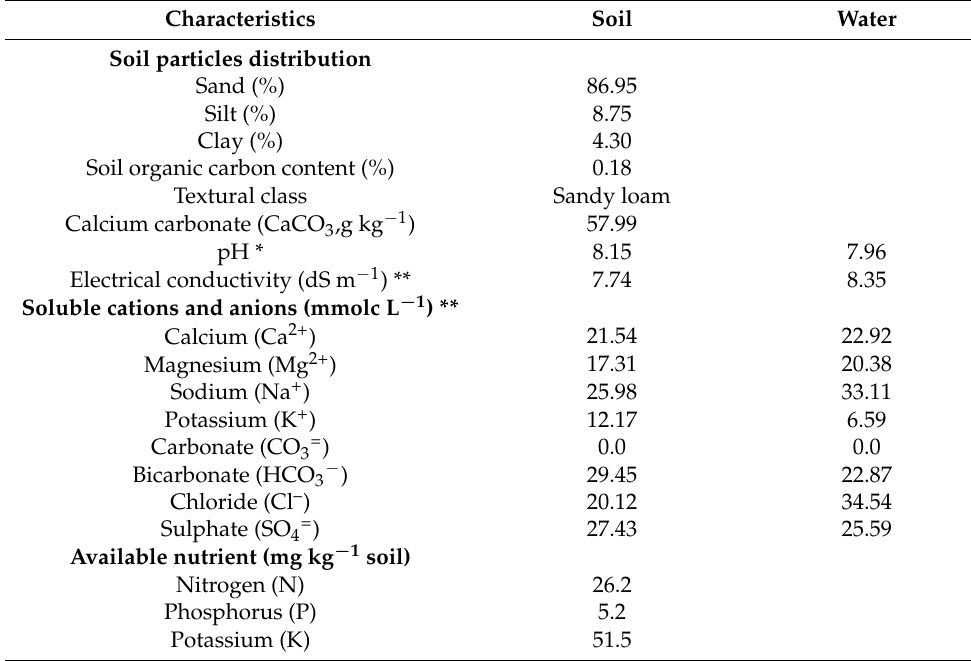
Table 2. Chemical properties of soil and irrigated water at the experimental site. Characteristics